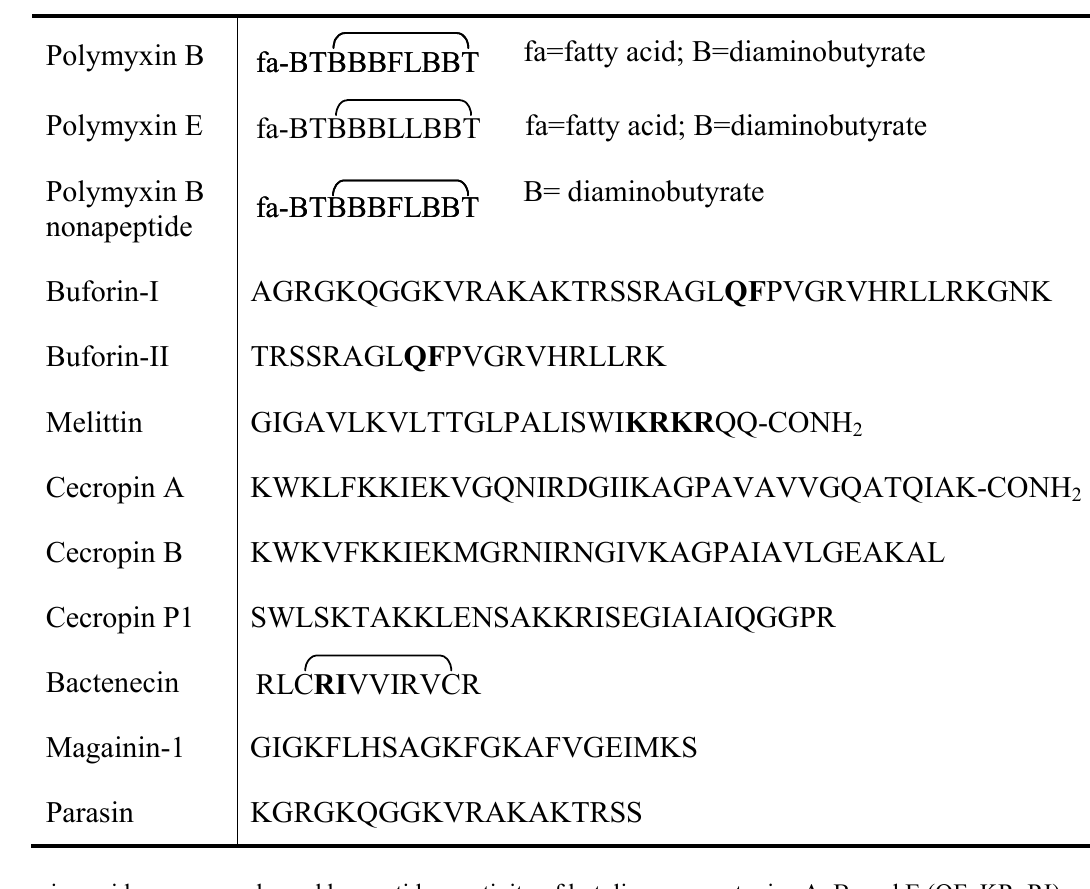
Table 1. Amino acid sequences of relevant AMPs and those used in this